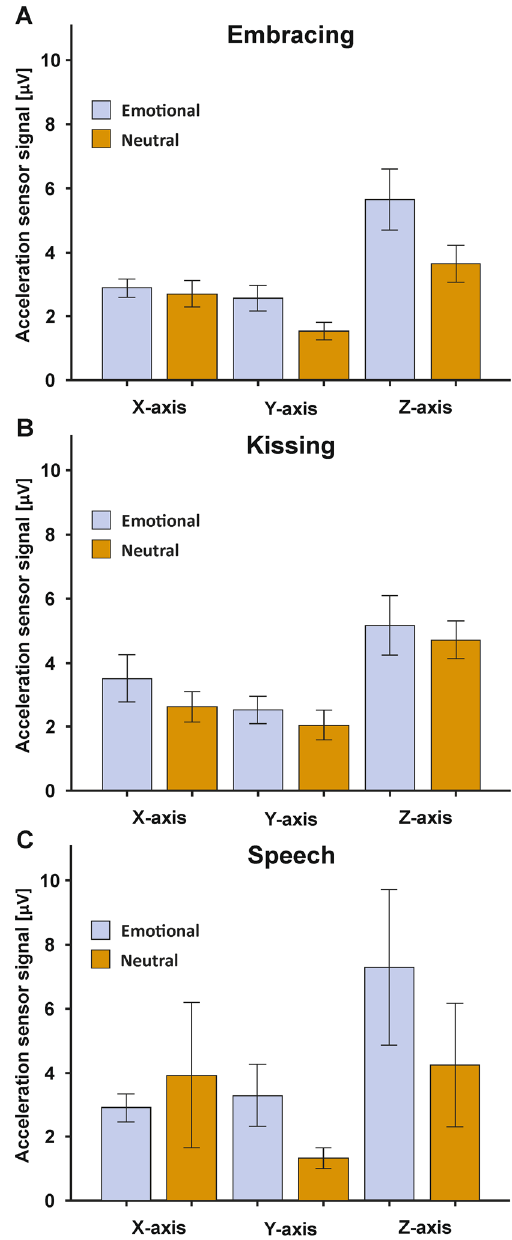
Figure 5. Acceleration sensor signals in the embracing ( A ), kissing ( B ) and speech condition ( C ) for the X-.Y- and Z-axis orientation. Error bars represent